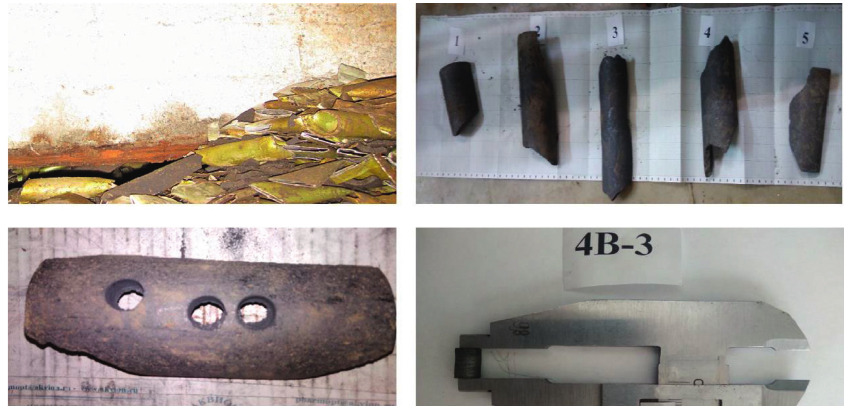
Figure 4: Fragments of sleeves removed from storage before and after core sampling.